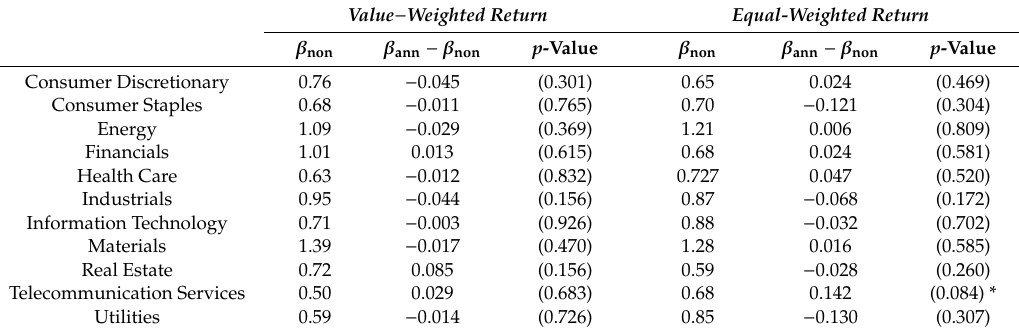
Table 2. A comparison of beta on a-day and beta on n-day for industry